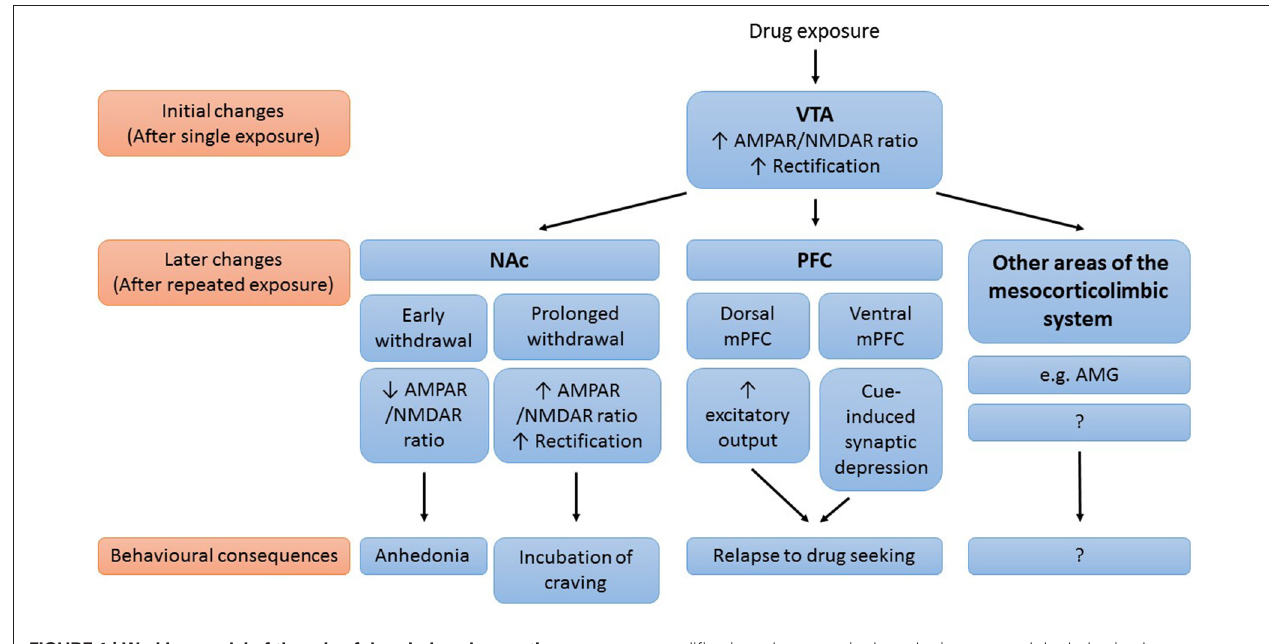
FIGURE 1 | Working model of the role of drug-induced synaptic plasticity in the mesocorticolimbic system in drug addiction . Simplified schematic of the mesocorticolimbic brain areas known to be affected by drug-induced plasticity, important synaptic